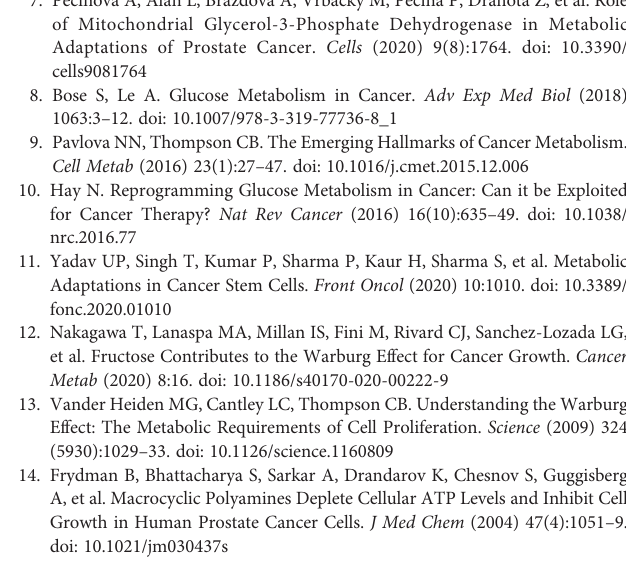
Supplementary Figure S1 | Identi fi cation of differential expressed genes in TCGA. (A) Heatmapofthedifferential expressedgenesinTCGA. (B) Volcanoplotof the differential expressed genes in TCGA. Supplementary Figure S2 | Expression pattern and DFS of glycolysis-related genes in TCGA. (A – C) Expression pattern of ADH1B (A) , ADH5 (B) , NUP210 (C) in tumor tissues and normal tissues. (D-F) DFS of ADH1B (D) , ADH5 (E) , NUP210 (F) in prostate cancer patients. Supplementary Figure S3 | Expression of candidate fi ve glycolysis-related genes based on external dataset (GSE70770). (A-E) . Expression of HMMR (A) , KIF20A (B) , ANKZF1 (C) , GPR87 (D) , PGM2L1 (E) in cancer tissues and normal tissues Supplementary Figure S4 | Relationship between glycolysis-related genes with SLC2A1 or LDHA. (A-C) Relationship between SLC2A1 with HMMR (A) , GPR87 (B) , ANKZF1 (C) in TCGA. (D, E) Relationship between LDHA with ANKZF1 (D) , PGM2L1 (E) in TCGA. Supplementary Figure S5 | Knockdown ef fi ciency con fi rmation of glycolysis- related genes in prostate cacner cell lines through qRT-PCR. (A – E) Expression of GPR87 (A) , ANKZF1 (B) , HMMR (C) , PGM2L1 (D) , KIF20A (E) in prostate cancer cells. Supplementary Figure S6 | Glucose consumption and lactic acid production in glycolysis-related genes. (A) Glucose consumption in HMMR, ANKZF1, GPR87 knock down group. (B) Lactic acid production in PGM2L1, ANKZF1 knock down